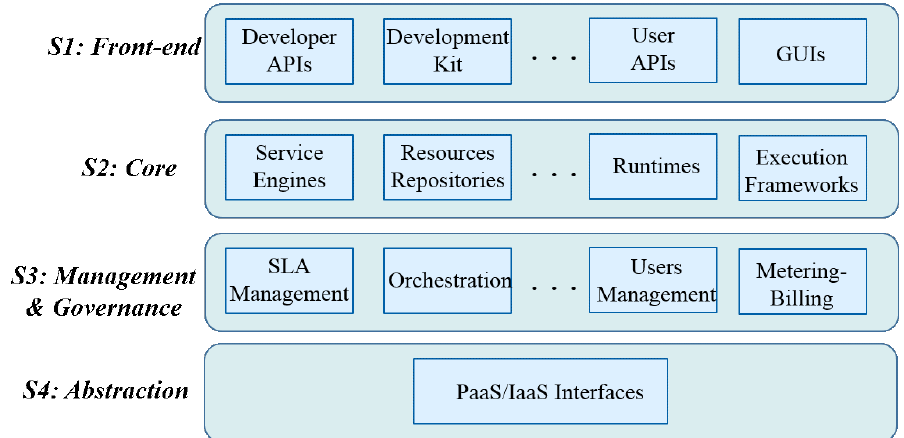
Figure 1. IBM Platform as-a-Service (PaaS) reference